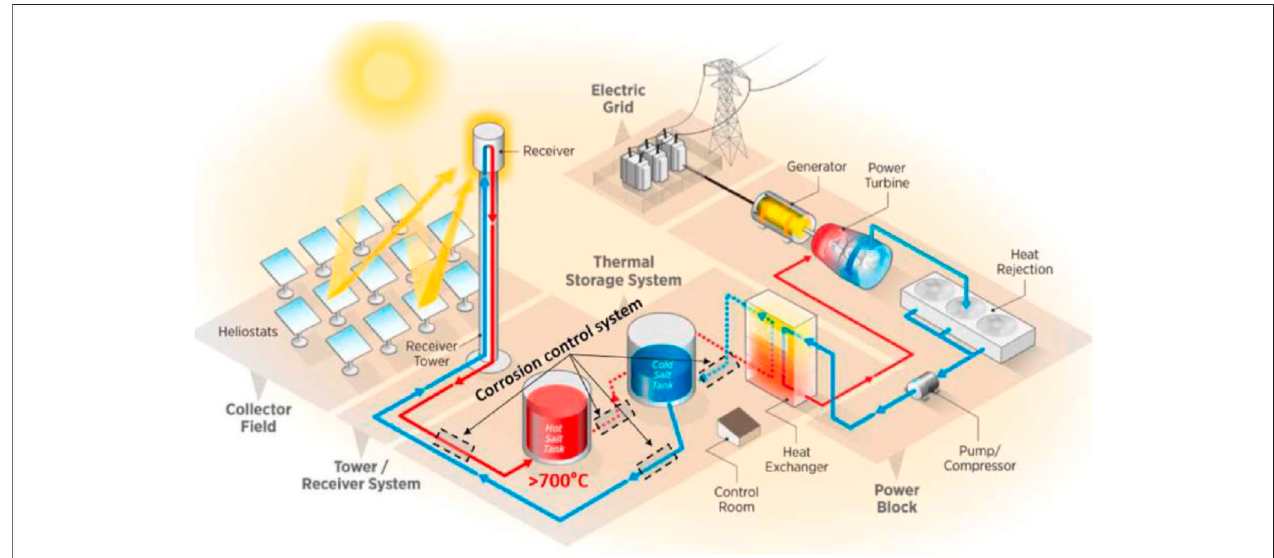
FIGURE 1 | Concept of next-generation CSP plant. Adapted from the study by Villada et al., (2021).